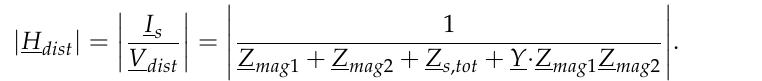
Figure 9. Magnitude (solid line) and phase (dotted line) of the current ratio H I —modified circuit for varying C eq = {5 pF, 1 nF, 50 nF } with detailed H I between 1 Hz and 200 Hz.